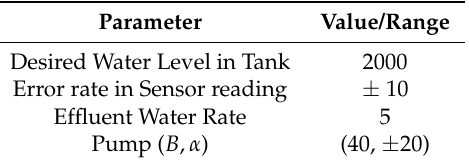
Table 5. Parameter settings for analysis of Kalman filter